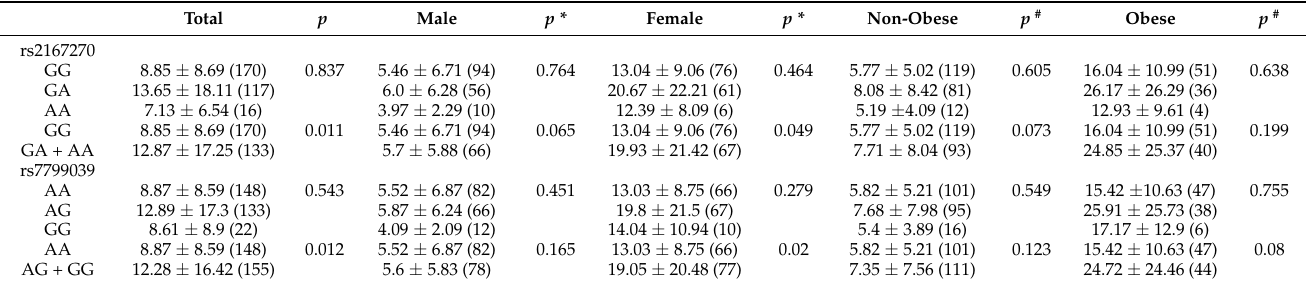
Table 3. Association of LEP SNPs with leptin levels in relation to sex and obesity status.